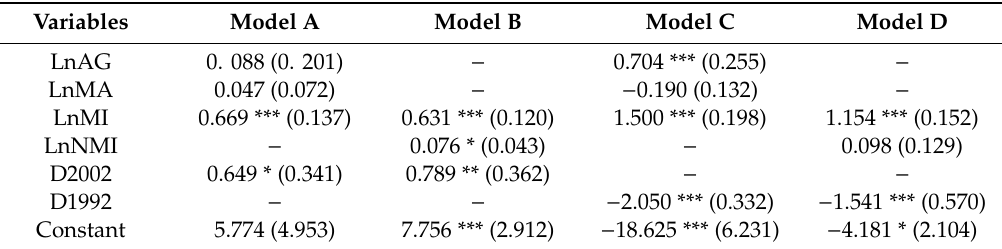
Table 8. Long − term coe ffi cients based on canonical co − integration regression